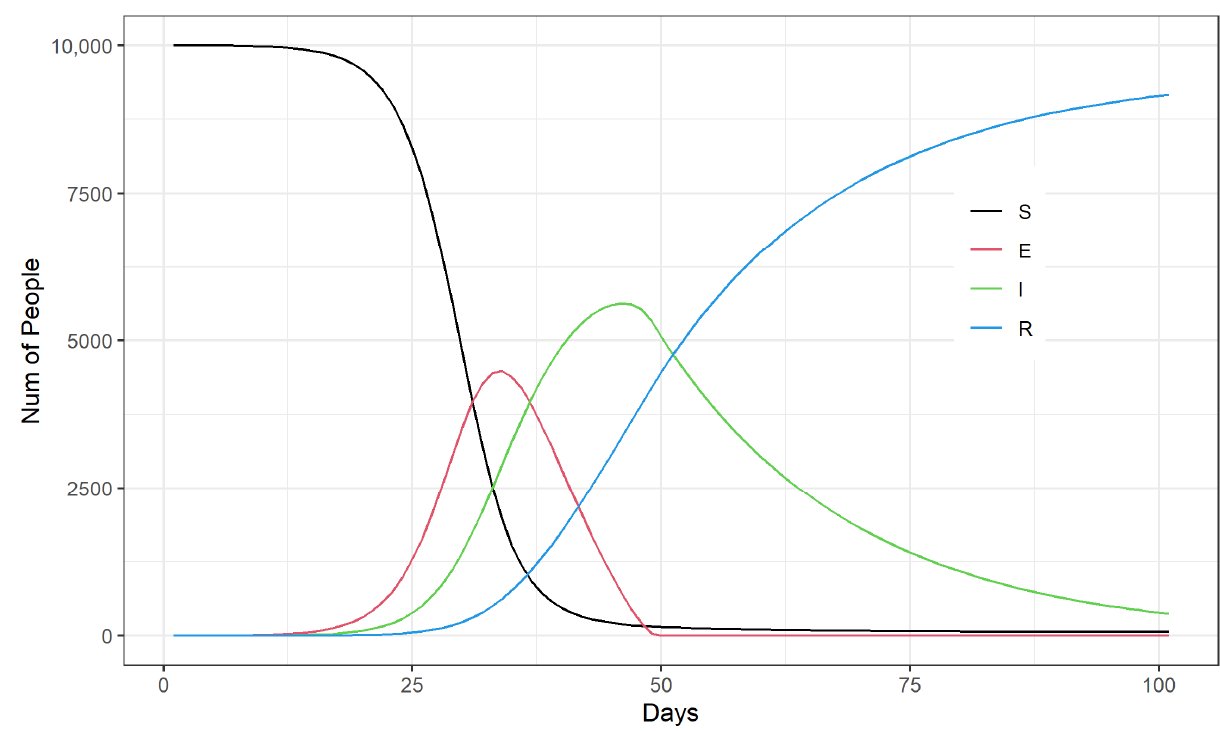
Figure A2. The influence of the daily testing capacity of 100 person on the evolutionary process of the epidemic; (The unit of the ordinate is “person”).